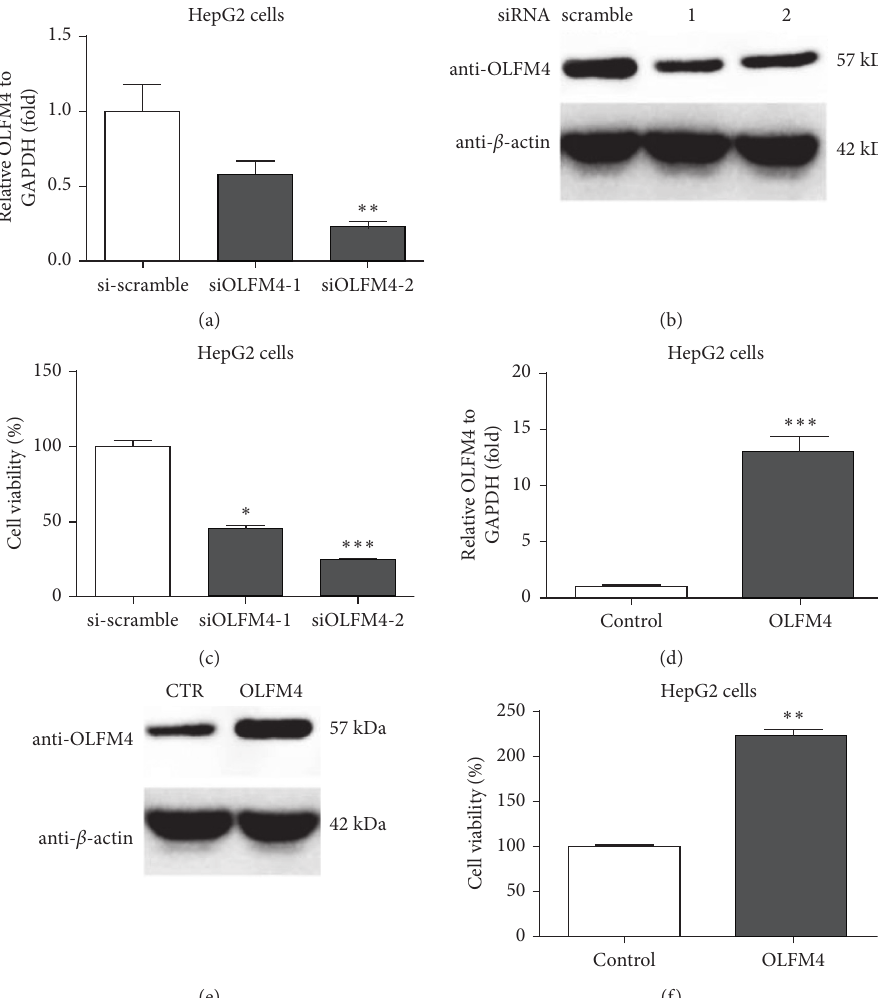
Figure 5: OLFM4 regulated liver cancer cell proliferation in HepG2 cells. (a) siRNAs against OLFM4 successfully inhibited the mRNA expression of OLFM4 in HepG2 cells measured by qRT-PCR assay ( ∗∗ P < 0 . 01); (b) siRNAs against OLFM4 successfully inhibited the protein level of OLFM4 in HepG2 cells measured by western blot assay; (c) siRNAs against OLFM4 could inhibit the proliferation of HepG2 cells ( ∗ P < 0 . 05, ∗∗ P < 0 . 01); (d) OLFM4 plasmid transfection could overexpress the gene in HepG2 cells detected by qRT-PCR assay ( ∗∗∗ P < 0 . 001); (e) OLFM4 plasmid transfection could upregulate the protein level of OLFM4 in HepG2 cells detected by western blot assay; and (f) OLFM4 plasmid could affiliate the proliferation of HepG2 cells ( ∗∗ P < 0 .